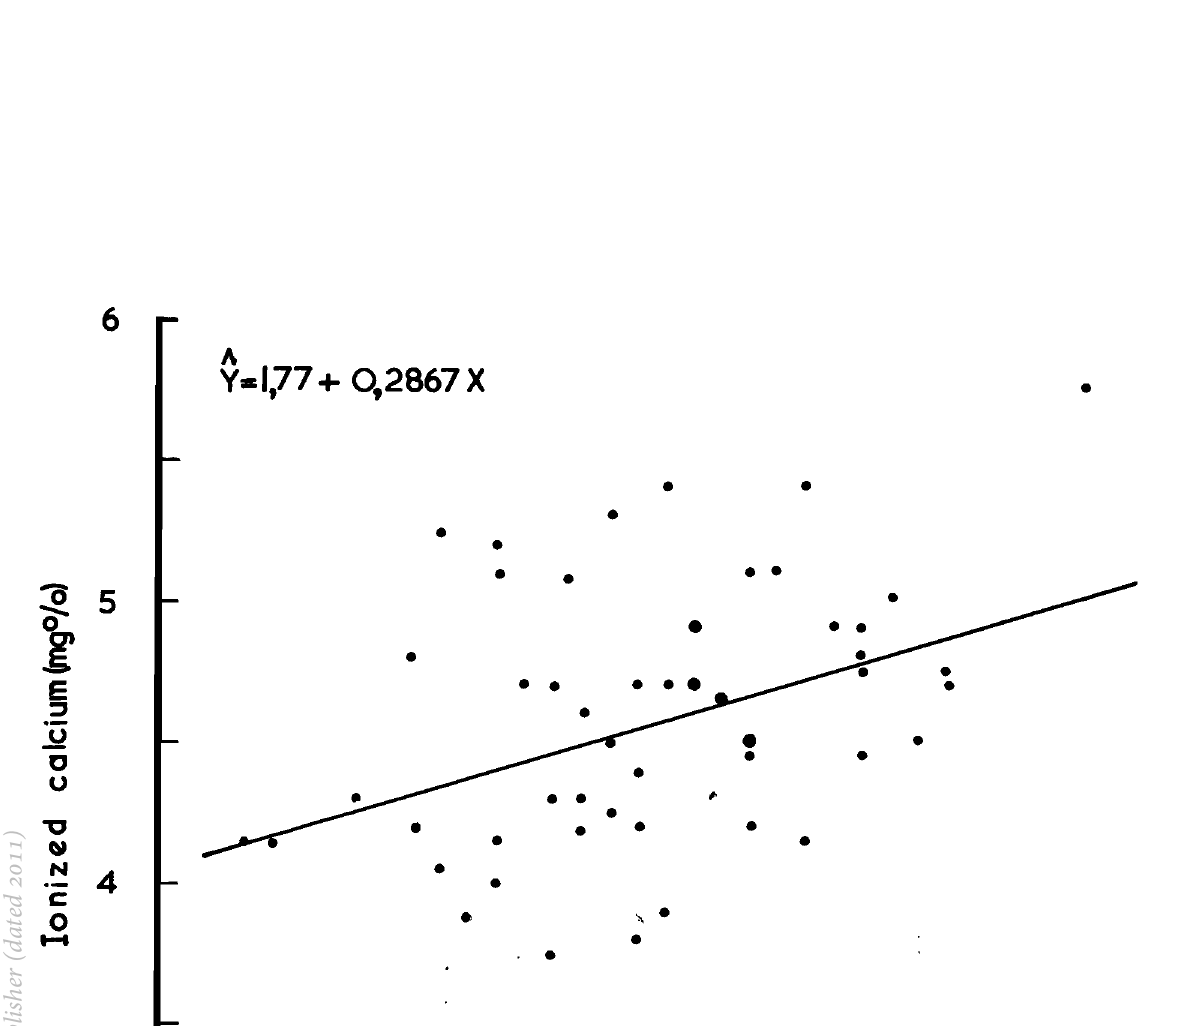
Fig.: The relationship between ionized calcium and total calcium.